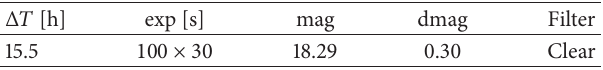
Table 12: GRB 110213A: observing log of BOOTES-1B.